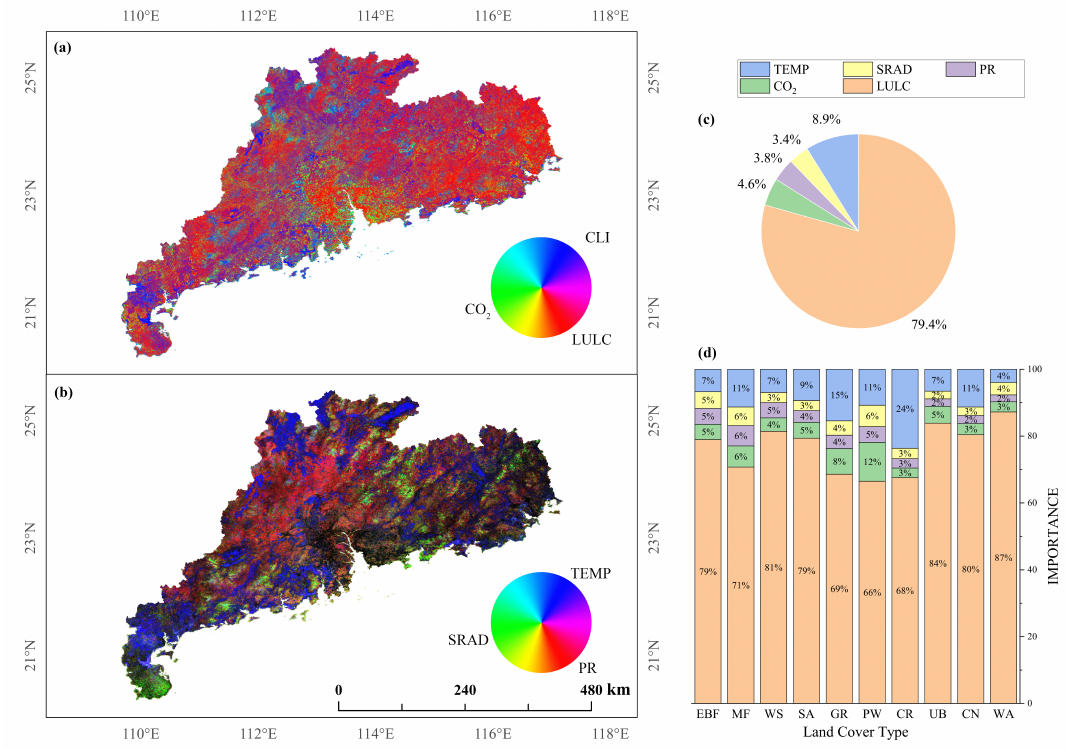
Figure 6. The contribution of each factor to NDVI given by random forest: ( a ) plotting the R, G, and B channels of LULC, CO 2 , and climate factors; ( b ) plots the R, G, and B channels of precipitation, shortwave radiation, and temperature; ( c ) shows the average of the contribution of each factor for each pixel; ( d ) shows the average contribution of each factor for each LULC